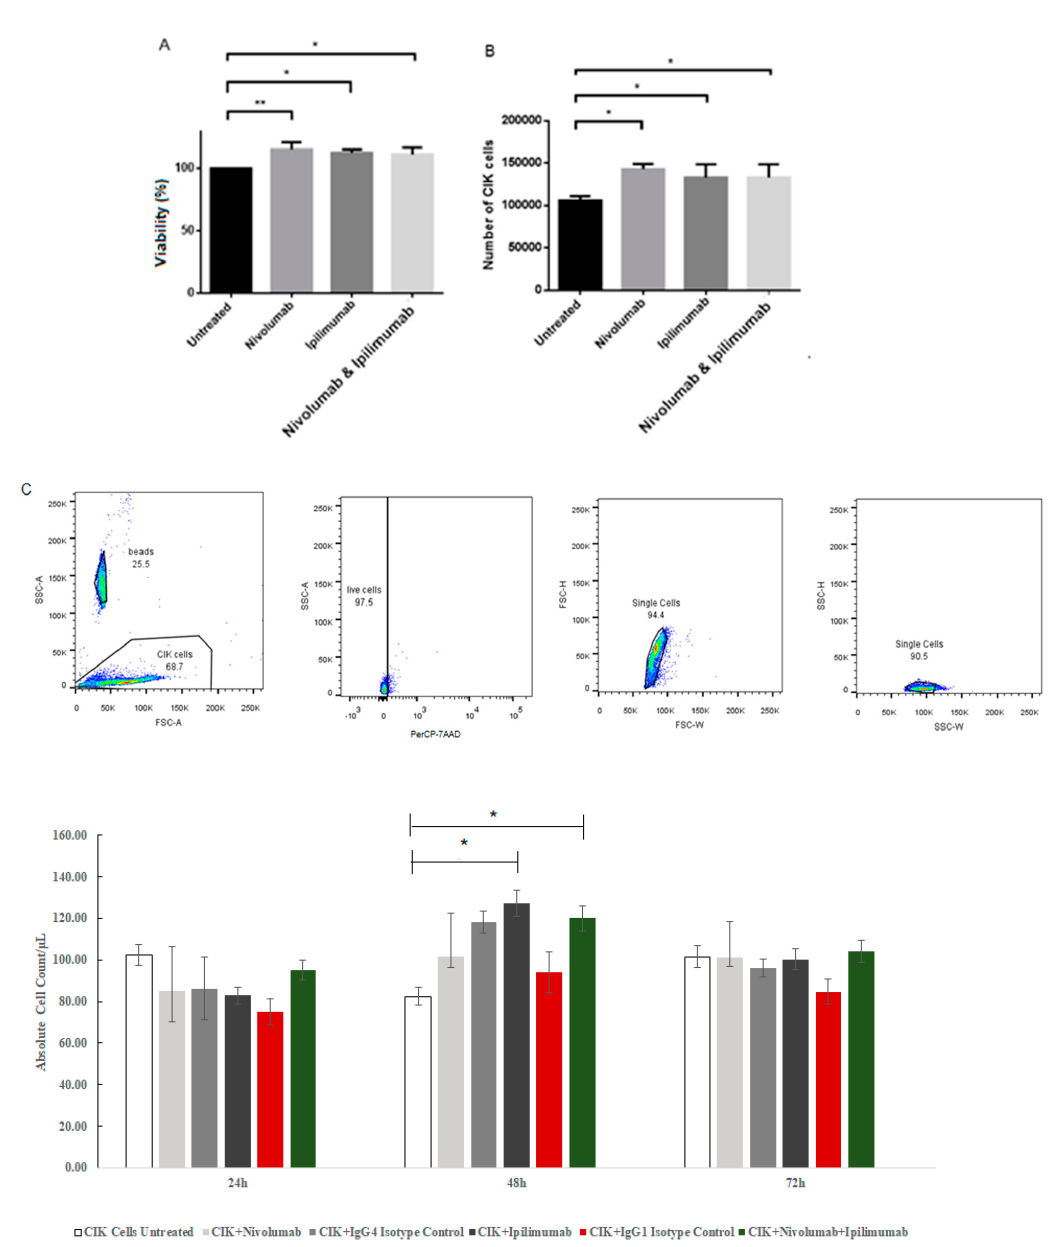
Figure 5. E ff ects of nivolumab and ipilimumab on the proliferation of CIK cells after 3 days of monoculture using a CCK-8 cell proliferation assay. n = 3 healthy donors. ( A ) Percentages of viable CIK cells after a combination treatment with nivolumab and ipilimumab compared to untreated CIK cells using CCK-8 assay, p value = 0.0087. ( B ) Number of viable CIK cells after a combination treatment with nivolumab and ipilimumab compared to untreated CIK cells conducted by trypan-blue staining , p value = 0.0227. * represents a p value < 0.05, ** represents a p value < 0.01. ( C ) Overview of the gating strategy and proliferation analysis utilizing Precision Count Beads™. Precision Count Beads™ were added and bead count and live cell count was determined by gating on beads and cells as shown, gating out PerCP-7AAD dead CIK cells. The number of total cells was determined as described in the protocol. * represents a p value <